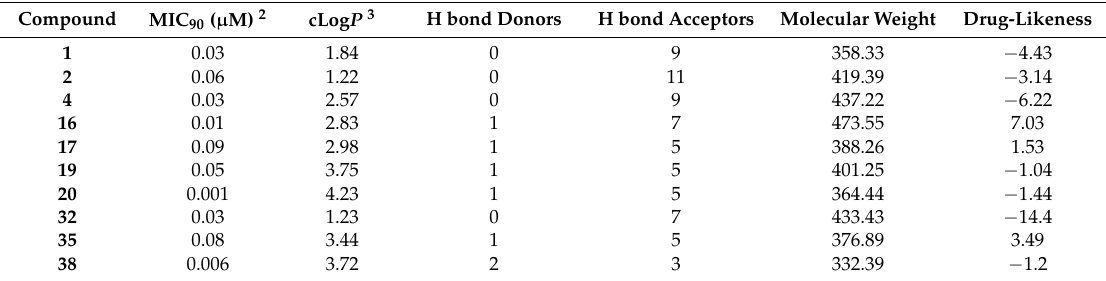
Table 1. MIC 90 values and calculated physicochemical parameters. 1